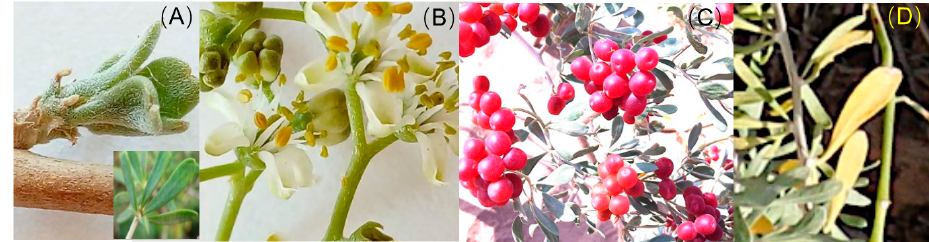
Figure 1 . Typical phenological events of N. tangutorum . ( A ) Leaf unfolding, ( B ) flowering, ( C ) fruiting, and ( D ) leaf coloring.